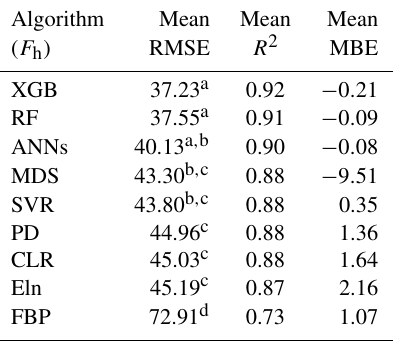
Table 8. The average metrics for F h gap-filling based on the algo- rithms, ranked by RMSE using the Tukey’s HSD test at the level of